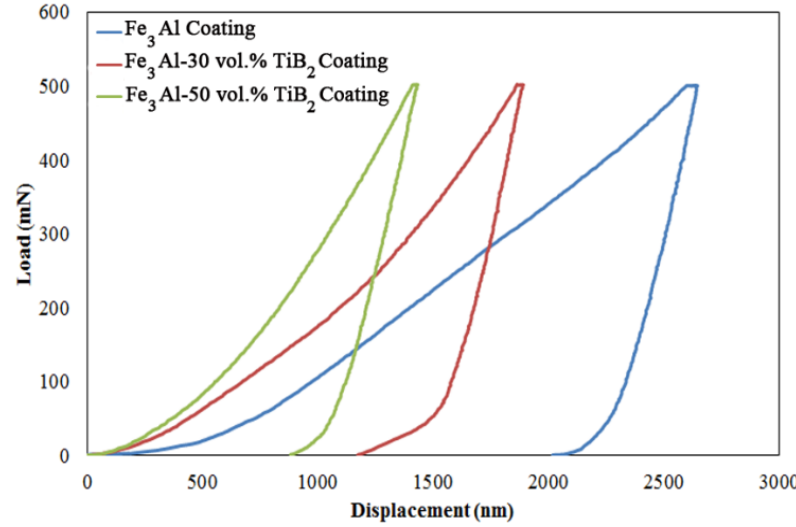
Figure 5. Typical load ‐ displacement curves of the coatings. Table 2. Microindentation hardness, reduced elastic modulus and H / E ratio of the coatings.